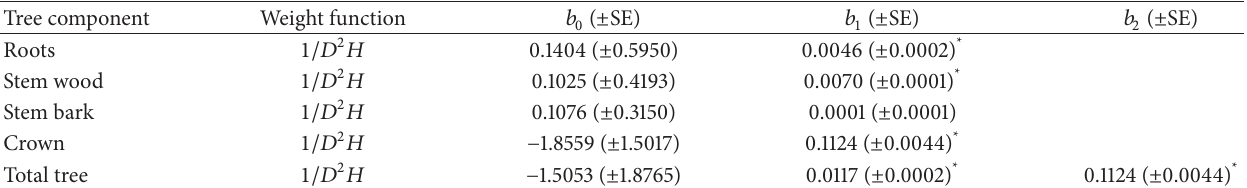
Table 2: Coefficients of regression of SUR using the system of the best linear models.